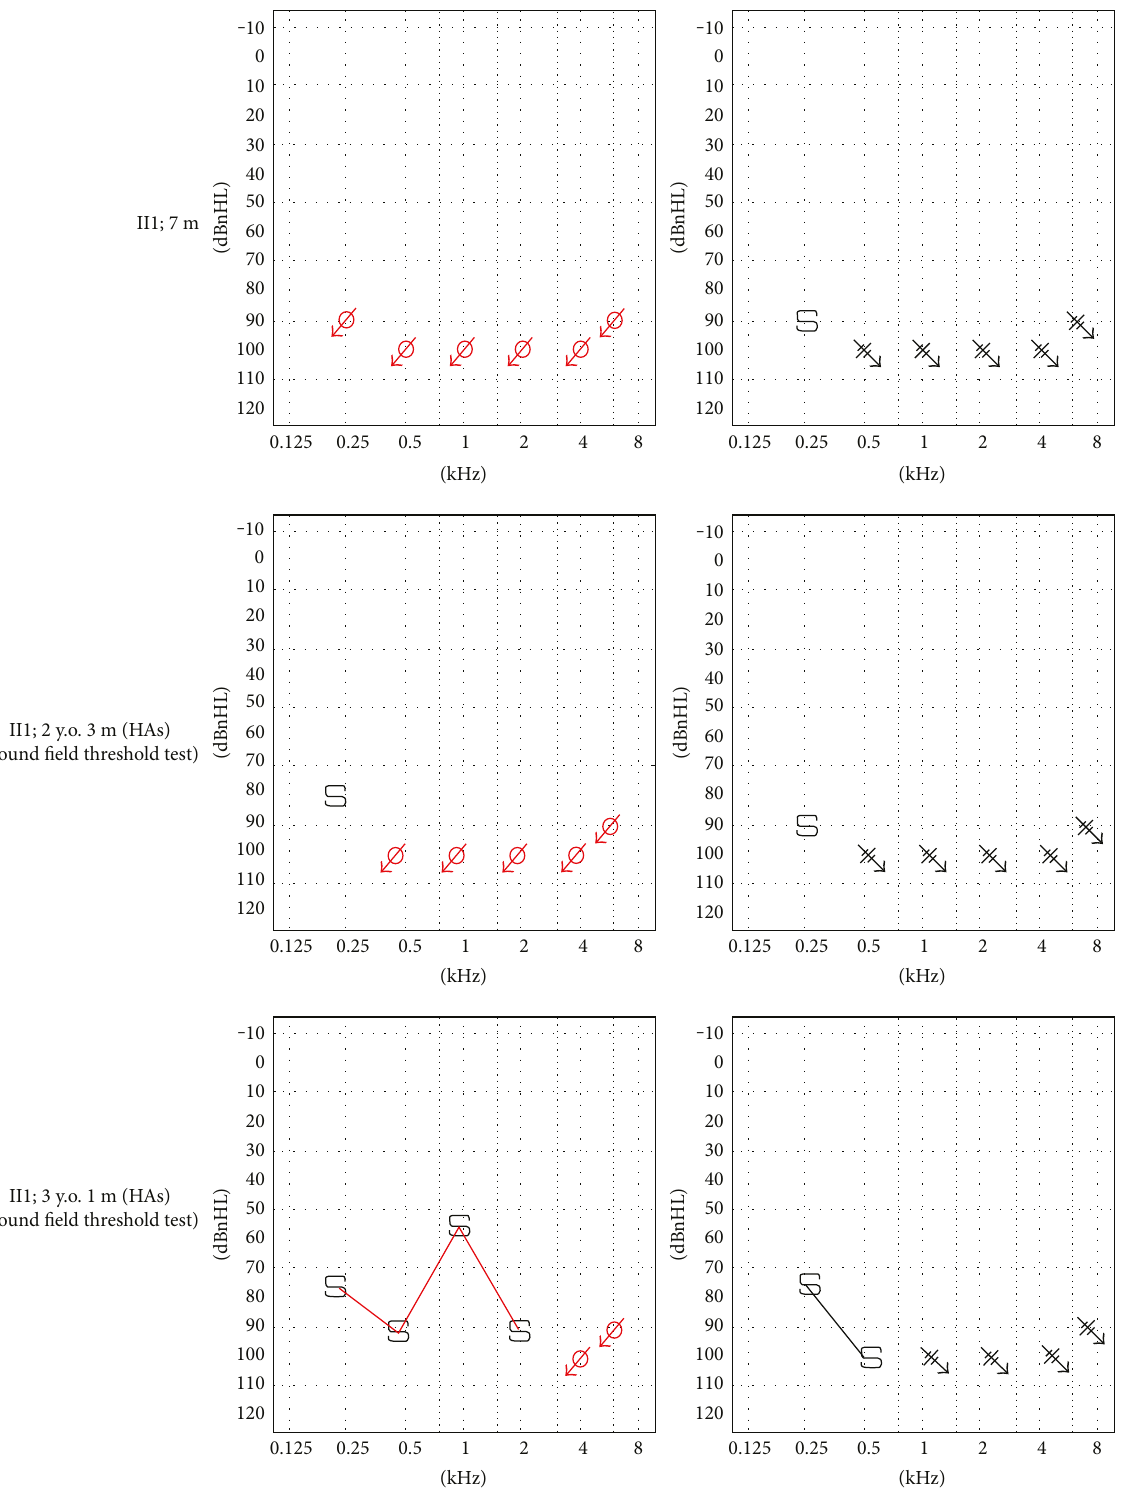
Figure 4: Pure tone audiometry. Visual reinforcement audiometry showed severe-profound SNHL at month 7. After hearing aids (HAs), sound fi eld threshold test showed improvement of hearing